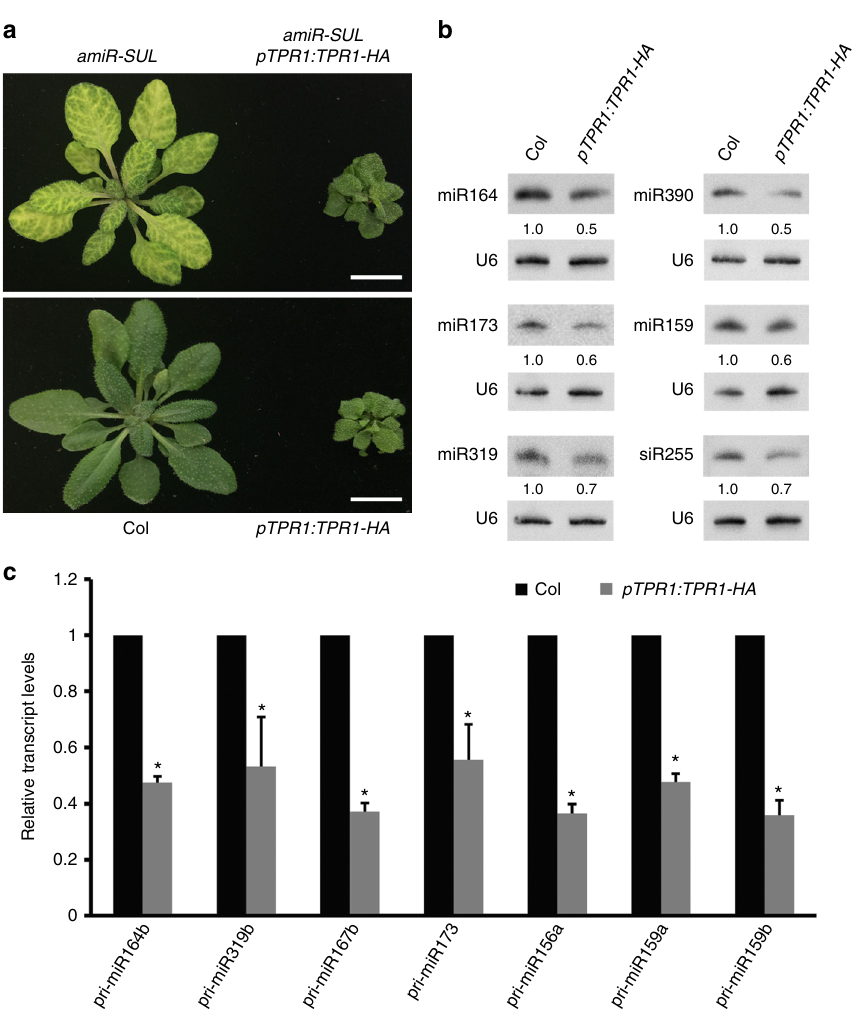
Fig. 6 The transcriptional corepressor TPR1 represses the transcription of MIR genes. a Plants of the indicated genotypes. pTPR1:TPR1-HA plants were similar in plant size to cpr1 aba1 plants (Fig. 2a). The amiR-SUL pTPR1:TPR1-HA plants displayed not only a dwarf phenotype but also reduced vein-centered bleaching. Bar = 1 cm. b Northern blots to detect fi ve miRNAs and an endogenous siRNA (siR255 from TAS1A/B/C ) in 15-day-old seedlings of wild type (Col) and pTPR1:TPR1-HA plants. Reduced accumulation was found for all these small RNAs in pTPR1:TPR1-HA plants. c Relative levels of seven pri-miRNAs in pTPR1:TPR1-HA vs. wild type (Col) as determined by real-time RT-PCR. Error bars represent standard deviations calculated from three biological replicates ( * Student ’ s t test: P < 0.05). Source data are provided as a Source Data fi